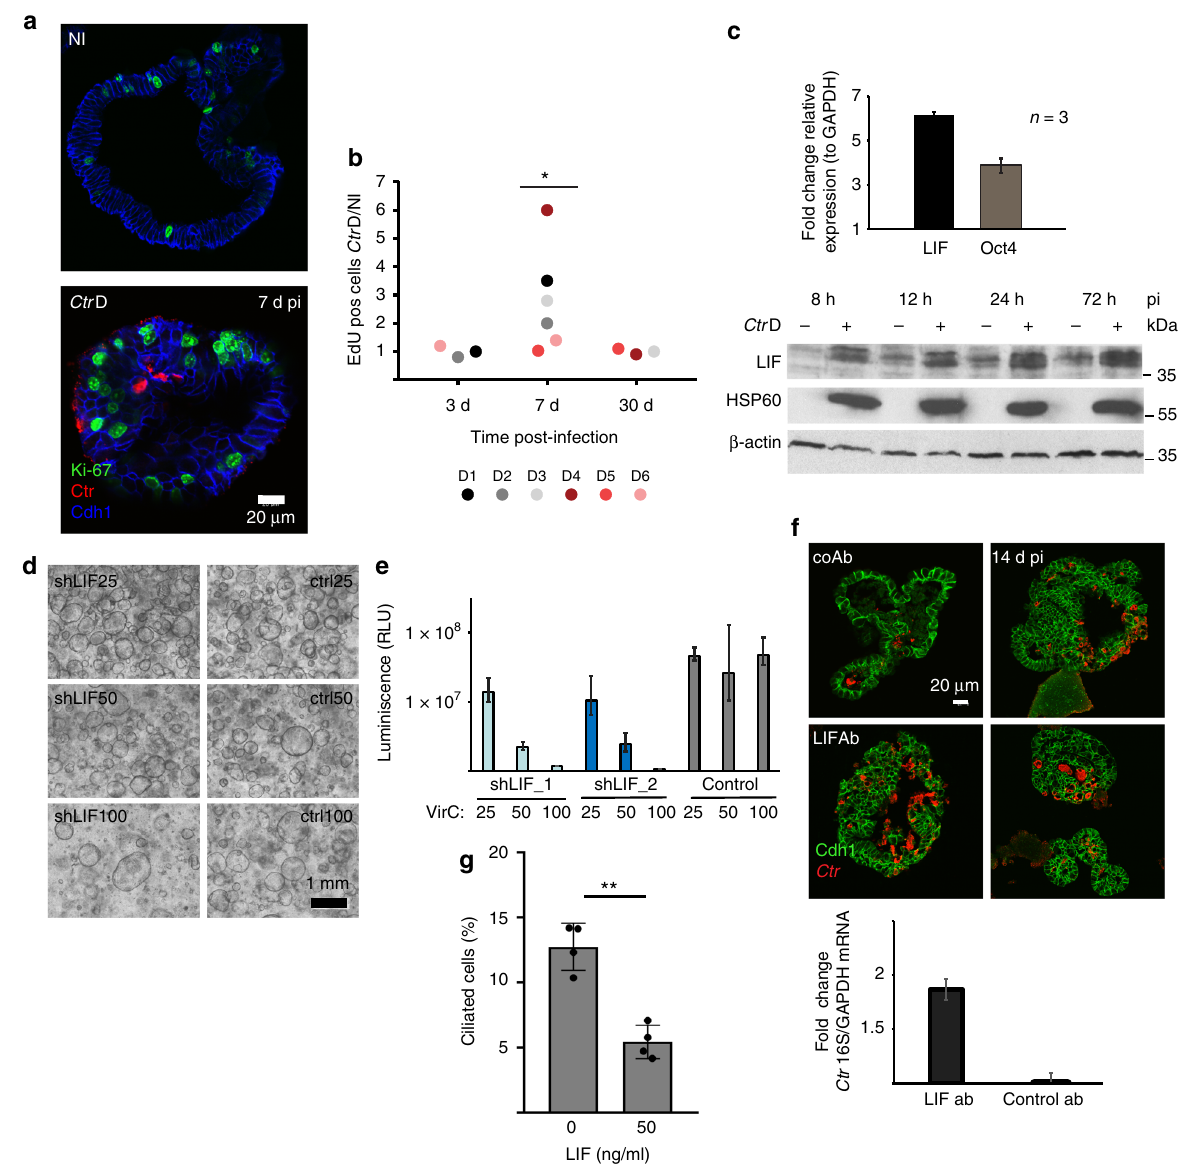
Fig. 2 LIF controls organoid homeostasis and limits replication of Ctr in the epithelium. a Confocal images showing that in infected organoids actively proliferating Ki67 + cells (green) are more frequent in cells neighboring infected cells (Ctr: red, Cdh1: blue) at 7d p.i. Scale bar: 20 µ m. b Quanti fi cation of the time course experiments from 6 Ctr infections (Donors D1-D6), by number of EdU-positive cells in the infected sample, as detected by FACS normalized to the control. Infected organoids exhibit a transient peak in proliferation at one week p.i., while long-term growth rate, measured at 30 days p.i. remains constant. Signi fi cance was determined by paired Student ’ s t -test of EdU measurement data sets in non-infected (NI) and infected ( Ctr D) conditions. c Upregulation of LIF and its target gene Oct4 in acute Ctr infection was validated by qPCR in three independent donors at 72 h p.i. Data are presented as mean ± sd. Induction of LIF starts from the early phase of Ctr infection, as increased protein levels are already detected at 8 h p.i. by western blot analysis of the fi rst 3 days. d Phase contrast images showing that lentiviral transduction of shRNA against LIF (at 25, 50, or 100 of viral units) greatly reduces the number of generated organoids in a dose-dependent manner. Ctrl: control vector pLKO.5. e The effect on organoid formation upon LIF knockdown by using different concentrations of virus particles (VirC) was quanti fi ed by ATP-based viability assay, which detects luminescence signal. Error bars represent technical variation between triplicate wells ± SD. f Inhibition of LIF activation by neutralizing antibody leads to increased bacterial load ( Ctr red, Cdh1 green) detected in confocal images at 14 d p.i.; scale bar: 20 µ m. The difference was quanti fi ed by qPCR at the same time point as the change in abundance of bacterial 16S relative to GAPDH level of the host cells. Data are representative of two independent experiments and presented as mean ± sd of technical replicates. CoAb: control antibody against H. pylori Cag A protein. g Active LIF, at 50 ng/ml promotes a secretory phenotype in the organoids as evidenced by reduction in the number of ciliated cells. Data are representative of two independent experiments. Quanti fi cation is performed as number of ciliated cells/nuclei in fi ve independent fi elds of view (dot plot) (>1000 nuclei/sample) ± sd represents variation between individual images. ** p < 0.01 ( p = 0.0057) was calculated by paired Student ’ s t